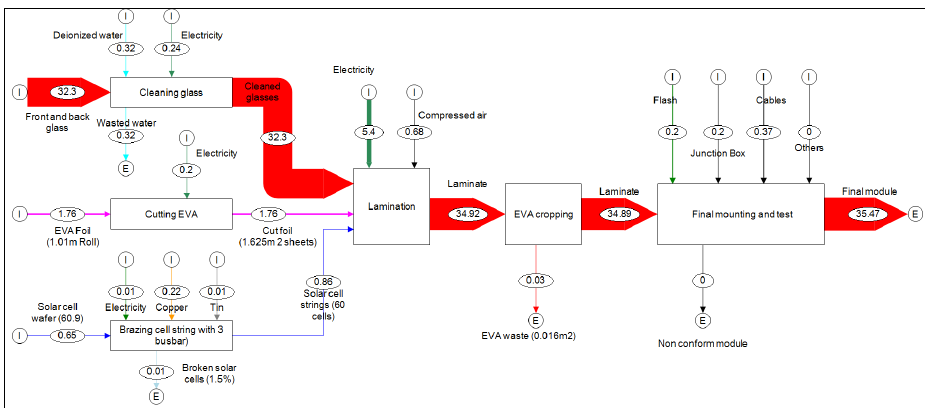
Figure 5. Material (kg) and energy (kWh) flows to produce 1.615 m 2 of a multi-coloured glass-glass PV laminate with 60 crystalline silicon cells, a junction box, and connecting cable. Arrowheads labelled I denote and import flow, indicating an input material or energy, while those labelled E denote an export flow, indicating a waste or loss. Data was derived from literature [27] and updated with material balance data and measured electricity consumption of the production steps and supporting processes provided by a German PV module manufacturer (courtesy of GES Gebäude- und Energiesysteme GmbH, 2018).